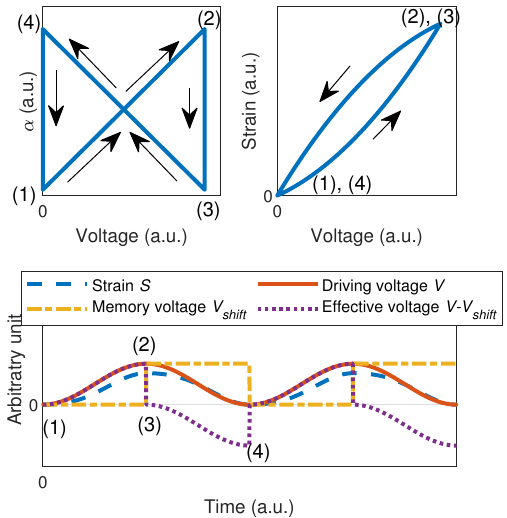
Figure 1. Original model principle (a.u. refers to “arbitrary